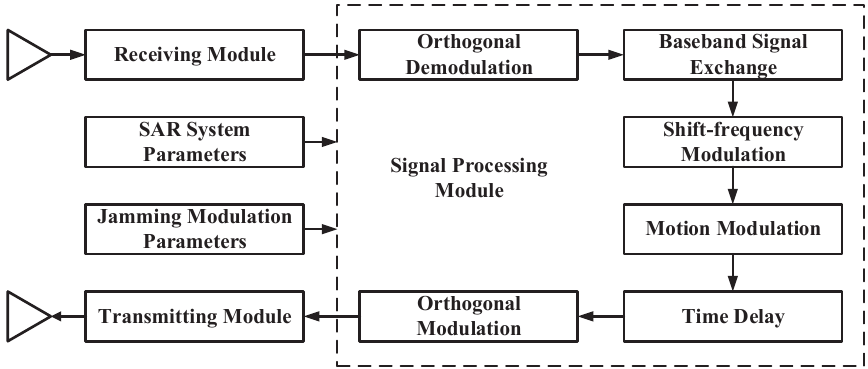
Figure 4. Principle diagram of controllable suppression jamming